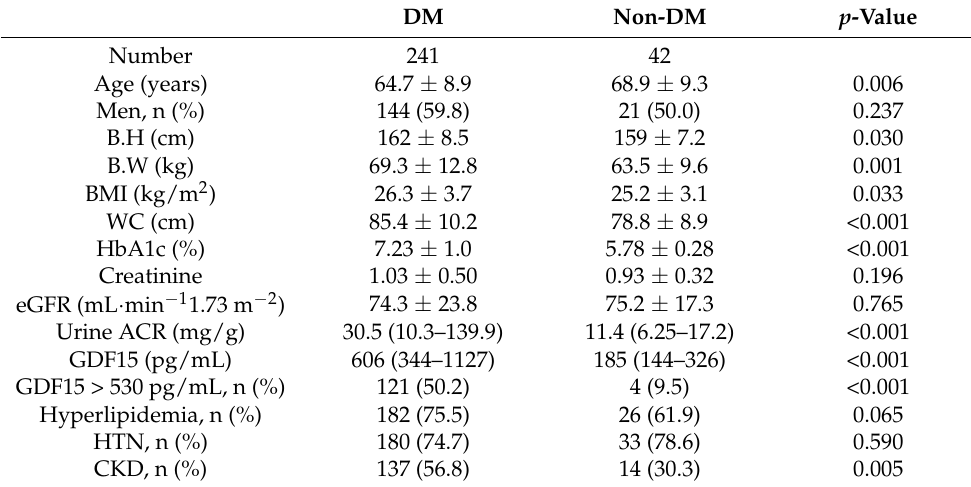
Table 1. Comparisons between DM and non-DM.